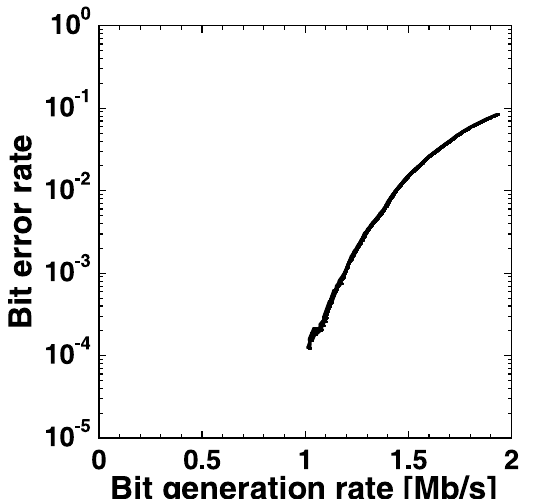
Figure 4. Relation between bit error rate (BER) and bit generation rate (BGR) for parameter-bit observation pairs of optical correlated random source for oblivious transfer. The two threshold values of the robust sampling are